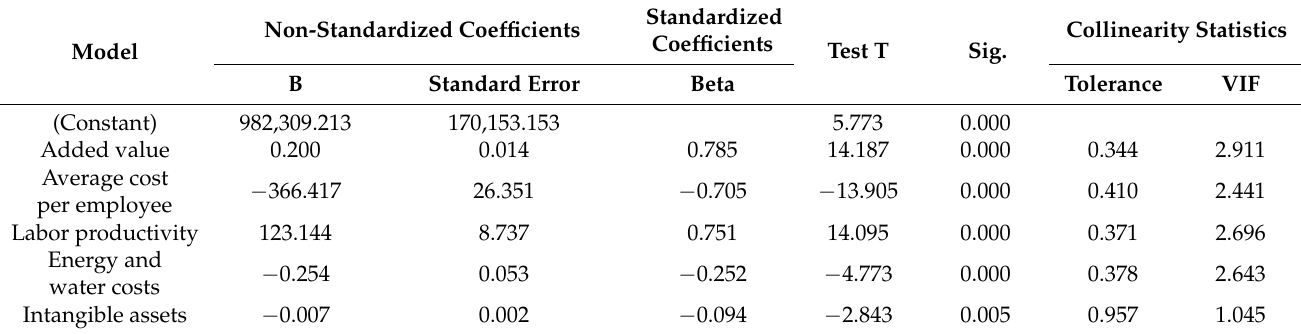
Table 6. Parameters of the realized econometric